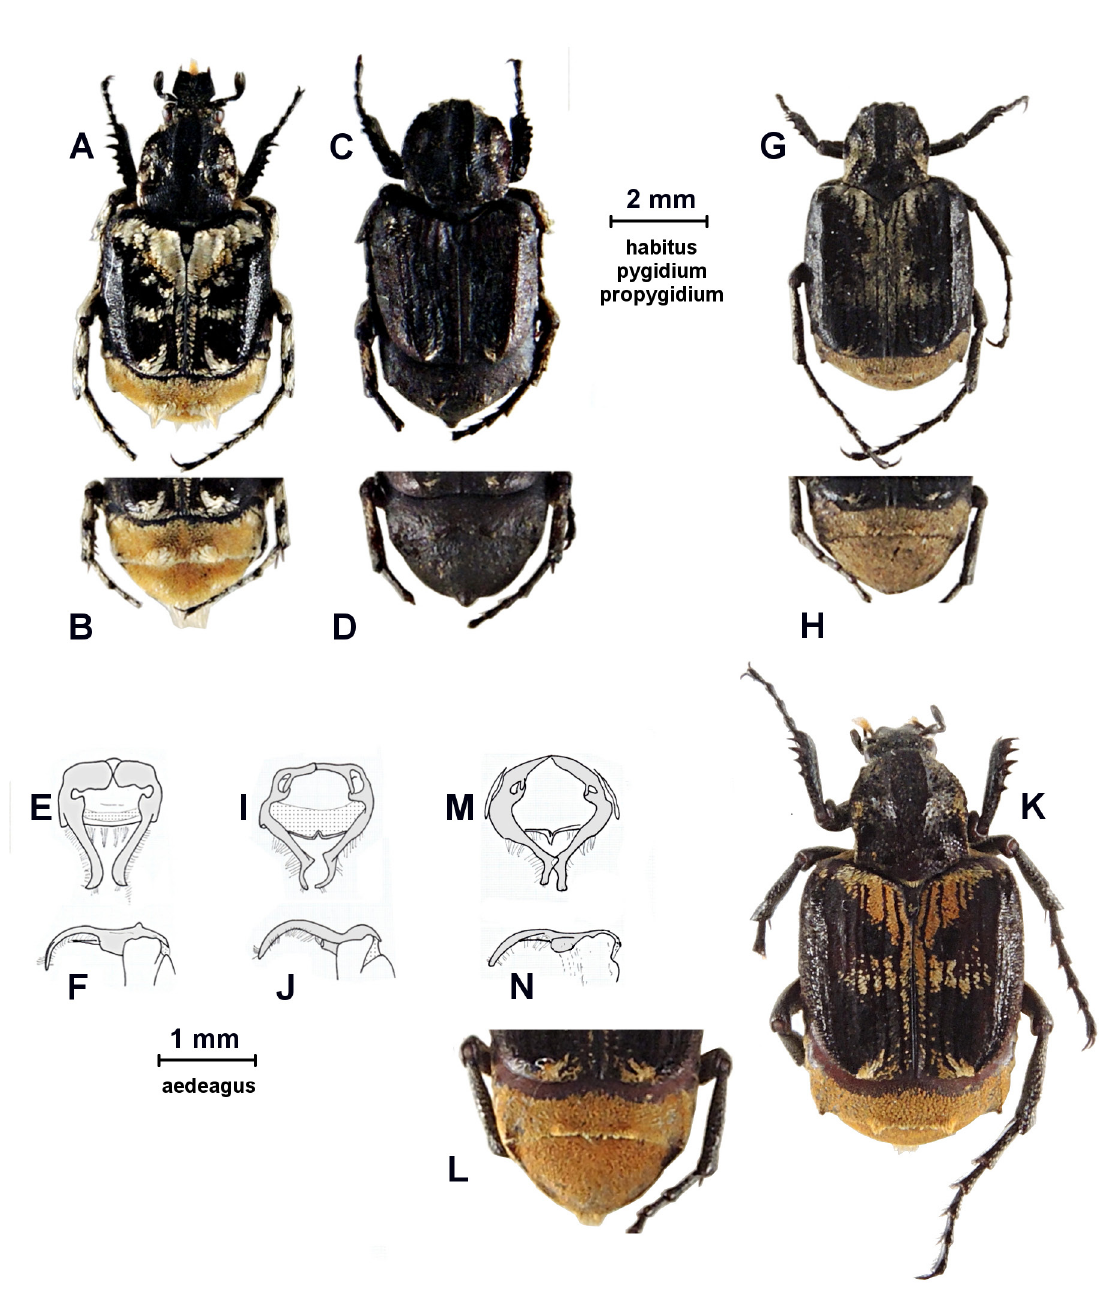
Fig. 8. A–F . Hybovalgus sexdentatus Arrow, 1944. A–B . ♂ (ERC). A . Habitus, dorsal view. B . Propygidium and pygidium. C–D . ♀ (ERC). C . Habitus, dorsal view. D . Propygidium and pygidium. E–F . PLT, ♂ (NHM). E . Aedeagus, dorsal view. F . Aedeagus, lateral view. G–J . Hybovalgus jordansi (Endrödi, 1952). G–H . ♂ (ERC). G . Habitus, dorsal view. H . Propygidiun and pygidium. I–J . PT, ♂ (HNHM). I . Aedeagus, dorsal view. J . Aedeagus, lateral view. K–N . Hybovalgus fulvosquamosus Moser, 1904. K–L . ♂ (ERC). K . Habitus, dorsal view. L . Propygidiun and pygidium. M–N . LT, ♂ (MNHUB). M . Aedeagus, dorsal view. N . Aedeagus, lateral view. Drawings: grey parts: parameres; white parts: